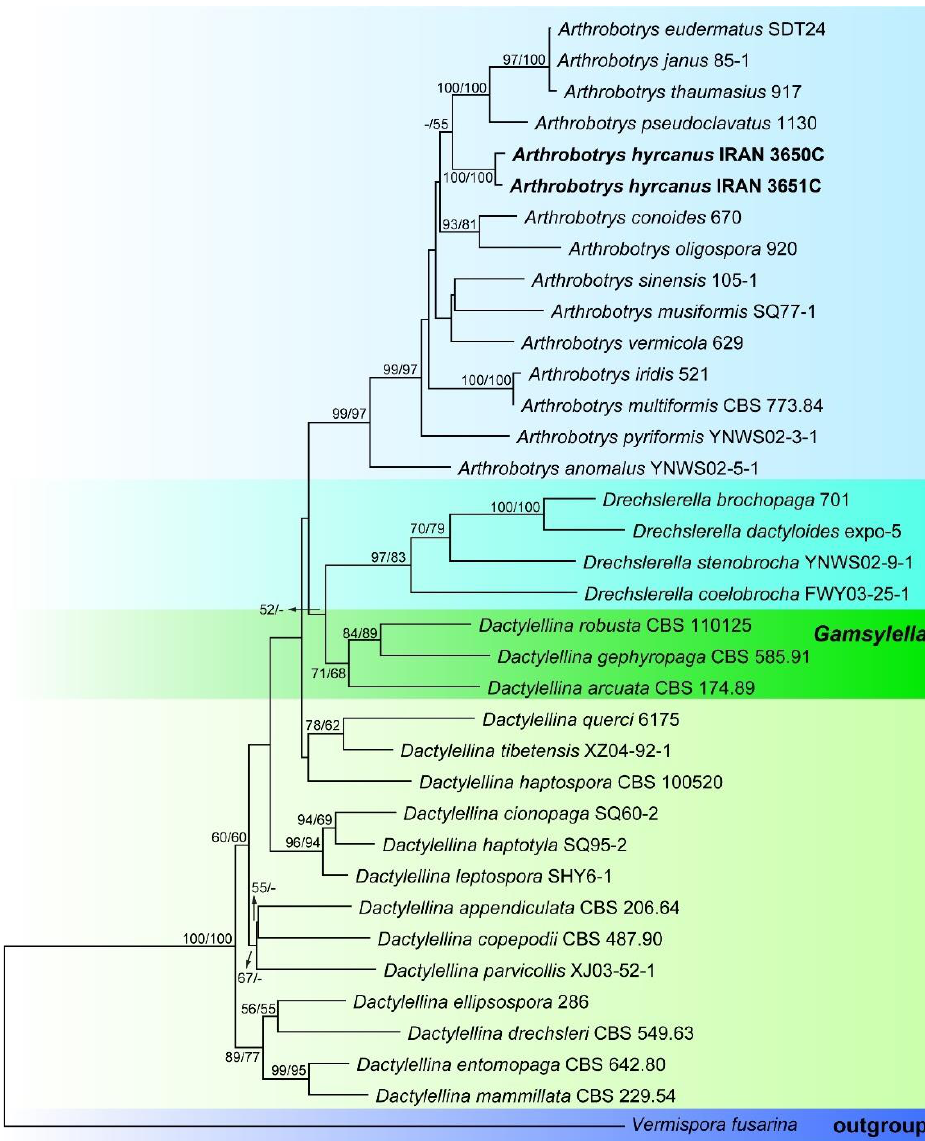
Figure 1. Phylogram of the best ML trees (lnL = −14,085.2515) revealed by RAxML from an analysis of the combined ITS – TEF1 matrix of selected Orbiliaceae. Strains in bold were sequenced in the current study. ML and MP bootstrap supports above 50% were given at the first and second positions, respectively, above or below the